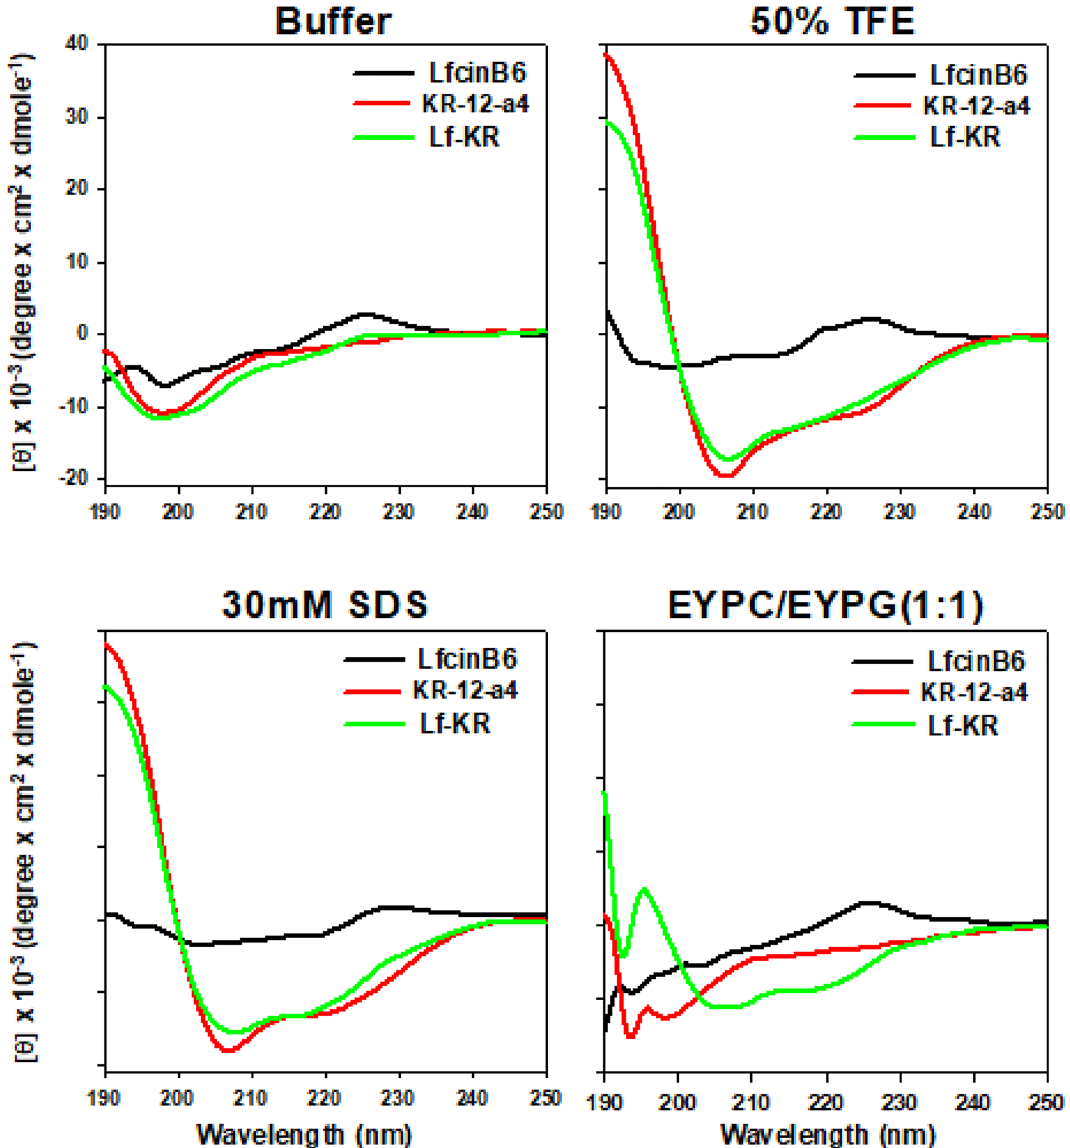
Figure 2. CD (circular dichroism) spectra of LfcinB6, KR-12-a5, and Lf-KR. The mean residue ellipticity was plotted against wavelength. The values from three scans were averaged per